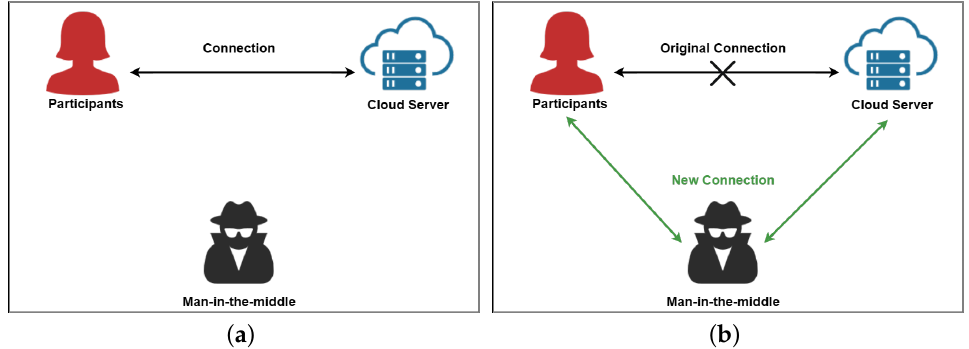
Figure 4. Man-in-the-middle attack; ( a ) normal communication; ( b ) post-attack